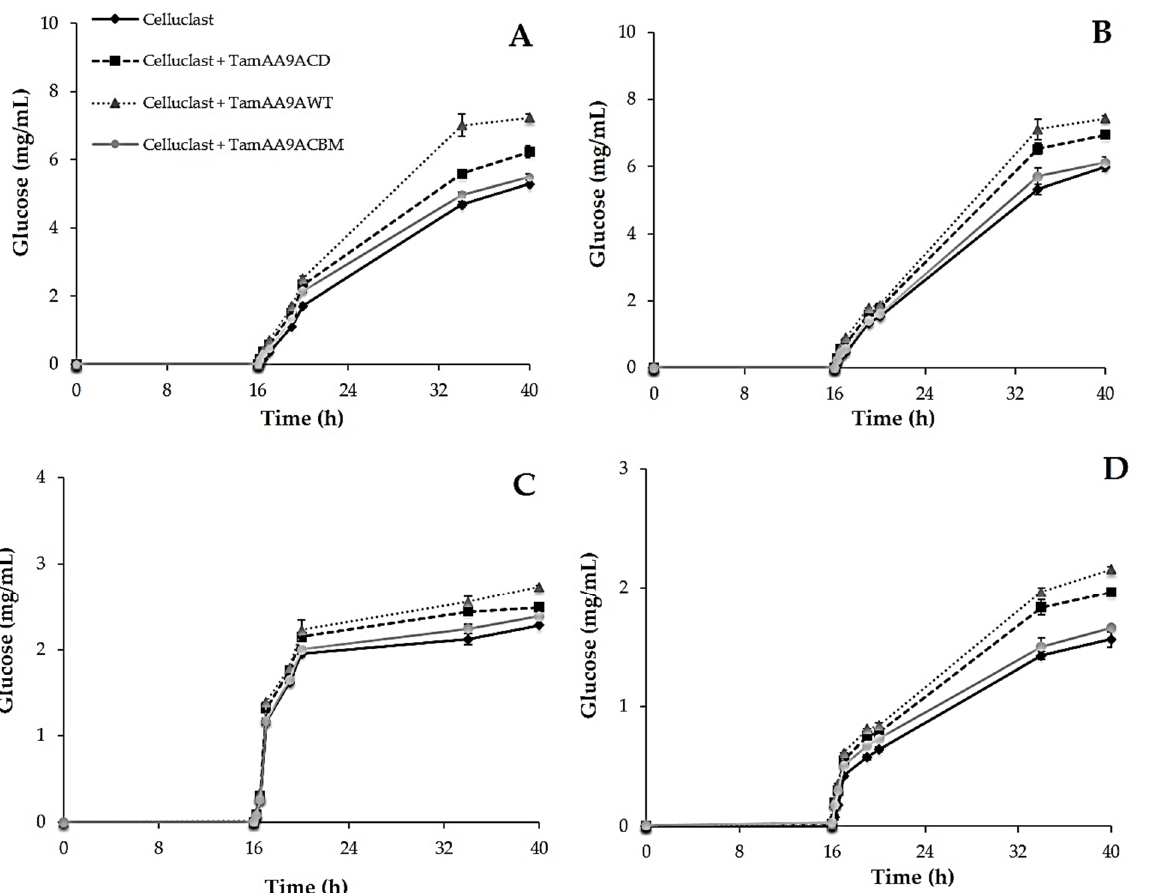
Figure 7. Glucose released by saccharification of different substrates pretreated for 16 h with TamAA9A ‐ WT, TamAA9A ‐ CD, or TamAA9A ‐ CBM. A 20 mg amount of each material was incubated for 40 h with 1 U of β‐ glucosidase activity of Celluclast 1.5L, at 50 °C and 1,200 rpm. ( A ) Crystalline cellulose. ( B ) PASC. ( C ) Wheat straw slurry. ( D ) Brewers spent grain. All reactions were performed in triplicate.